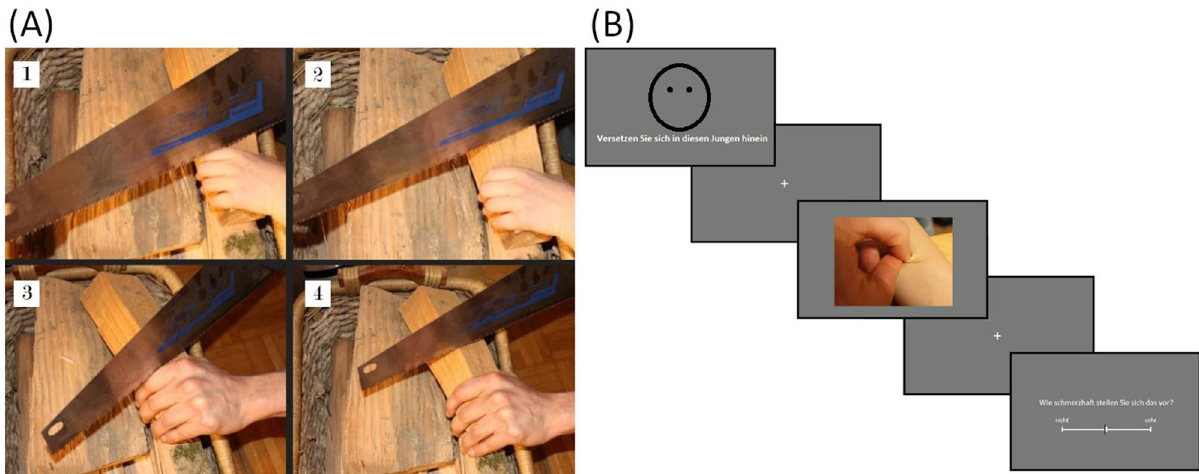
Figure 1. ( A ) Example for a scenario in all four variations: 1. child painful, 2. child neutral, 3. adult painful, 4. adult neutral. ( B ) Schematic of the neutral introductory face including a term for adult or child and the first picture of a trial followed by a